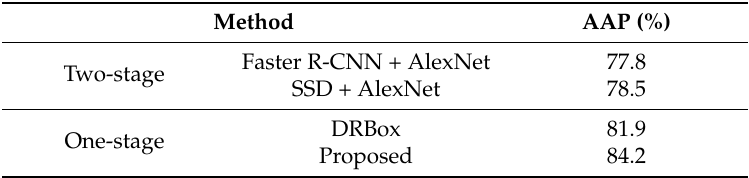
Table 2. Accuracy comparison between the two-stage and one-stage pipelines.